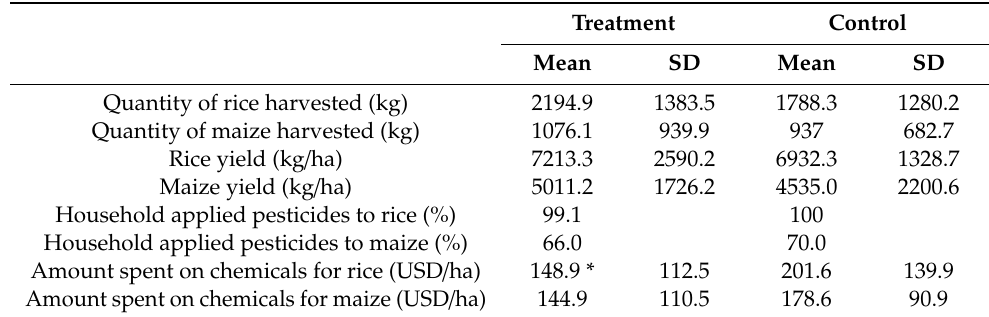
Table 5. Summary statistics of farm-level benefits reported by rice and maize farmers during the HHS in the last cropping season of